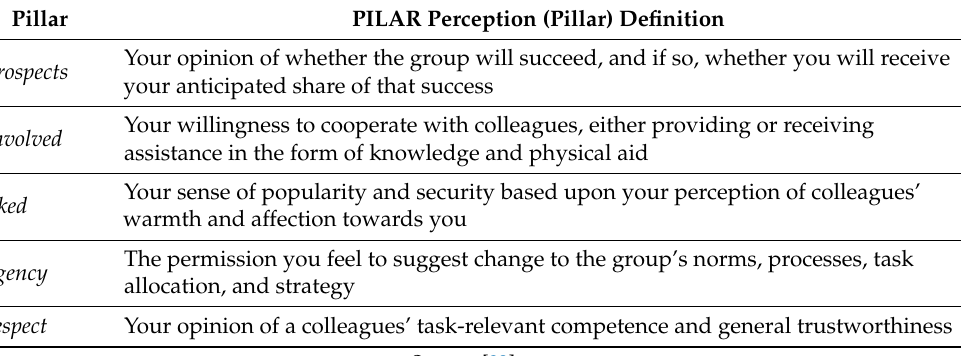
Table 1. Definition of each Pillar within the PILAR Model of